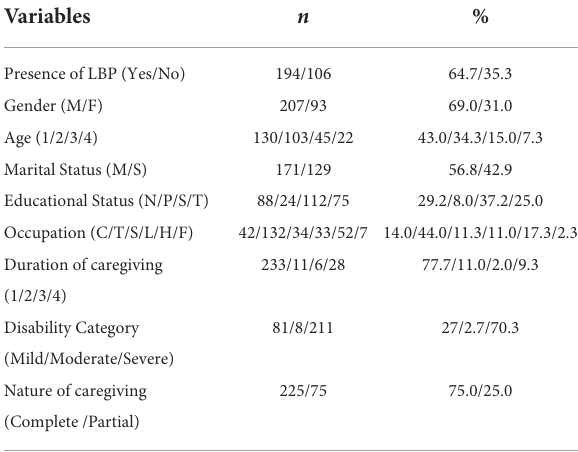
TABLE 1 Characteristics of the study participants.